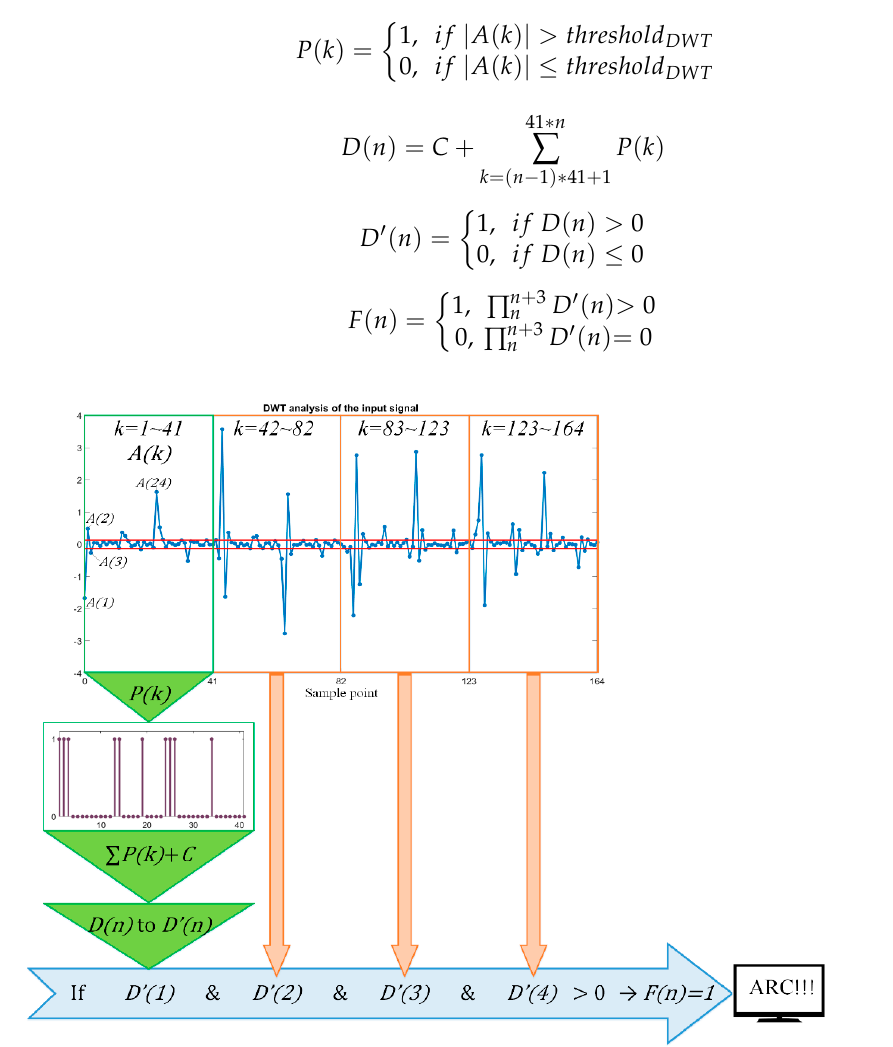
Figure 12. Violation check strategy.